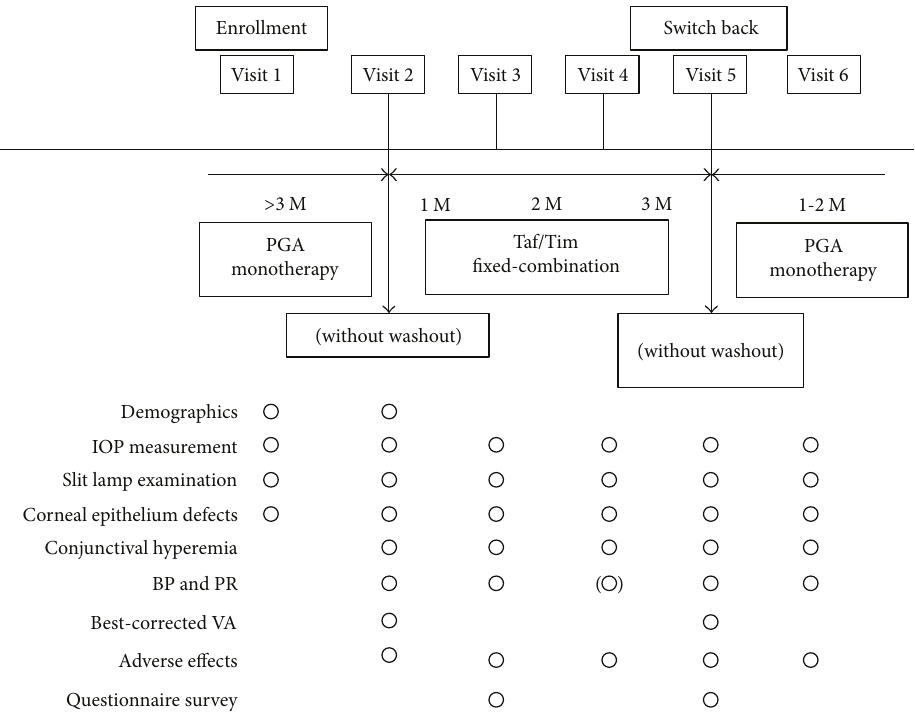
Figure 1: Study protocol. M: months; Taf/Tim: ta fl uprost/timolol; PGA: prostaglandin analog; IOP: intraocular pressure; BP: blood pressure; PR: pulse rate; VA: visual acuity.